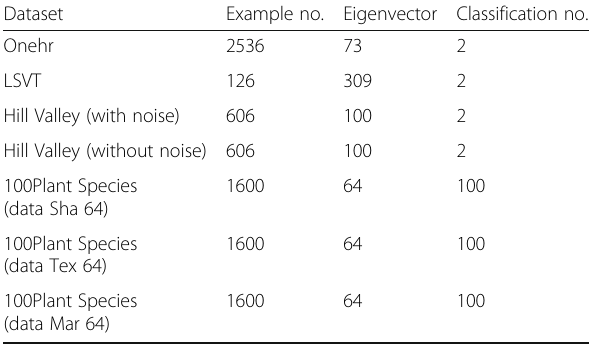
Table 5 UCI dataset used in the experiment Dataset